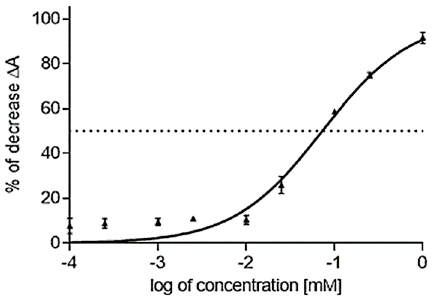
Figure 2. The dose-response curve of (–)-munitagine (IC 50 calculation of its AChE inhibitory activity).